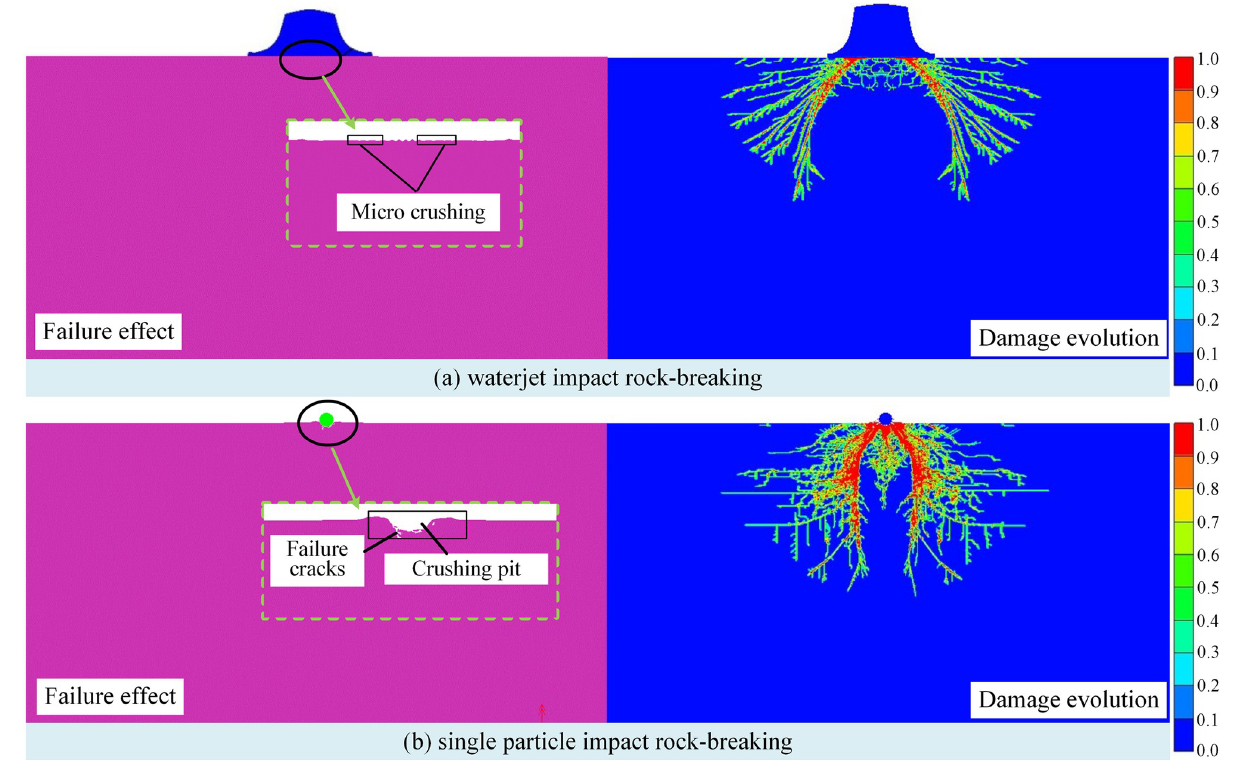
Based on the above modeling method, the simulation model and rock-breaking effect under waterjet impact and single particle impact are established and simulated dynamically, as shown in Fig 6. For waterjet impact, only a small amount of fracture appears on rock surface at the edge of jet impact area, while the particle impact not only causes plastic damage at the impact point, but also causes some cracks inside of rock. Therefore, according to simulation analysis, the rock-breaking effect is mainly impacted by particles, and waterjet can aggravate damage with the auxiliary role in rock-breaking process. Under multi-particles and jet impact, the dynamic simulation of rock-breaking is carried out, damage evolution and broken effect of rock under particle jet coupled impact is simulated. The failure effect and damage evolution status under multiple particles and waterjet impact on the same place (impact velocity is 200 m/s, particle size is 1 mm) is shown in Fig 7. According to the figure of rock failure effect, rock-breaking depth increases with the impact times, but is not only simply superposition. The main reason is that it will be formed the small damage area under the first impact, and also produced pits and many dominant and hidden cracks. When the particle impact rock again, it is easier to realize the larger fracture area and